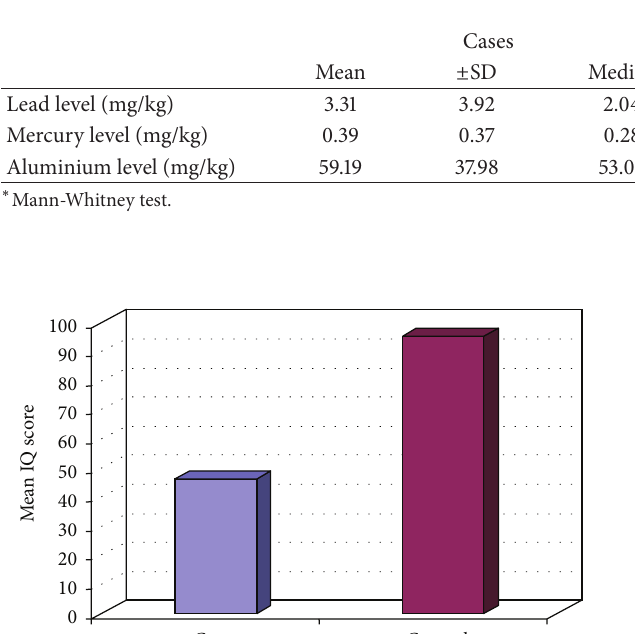
Figure 3: Mean aluminum level in hair in both